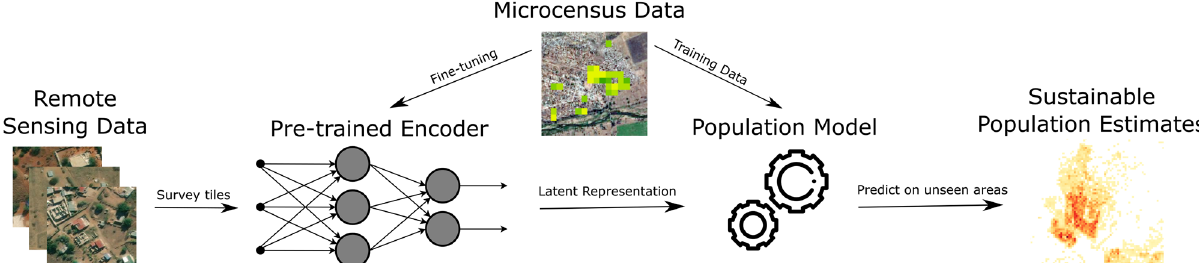
Figure 1. The figure illustrates our approach of sustainable census-independent population estimation, or SCIPE, using representation learning. Satellite images of surveyed grid tiles are mapped to vector representations through a pre-trained deep neural network, and a regression model is trained on the representation space to estimate population using microcensus. The pre-trained network can also be fine-tuned with microcensus to learn better representation indicative of